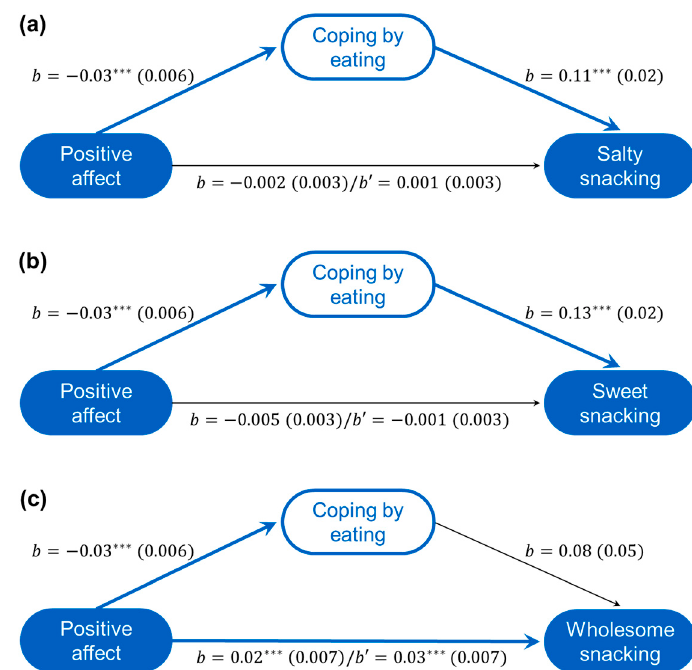
Figure 2. Positive affect associated with reduced eating to cope and increased wholesome snacking. Mediated models (unstandardized coefficients ( se )) of the relationships between positive affect and salty ( a ), sweet ( b ), and wholesome snacking ( c ) as mediated through coping by eating (including total effect ( b )/direct effect ( b’ ) between affect and snacking). *** p < 0.001.